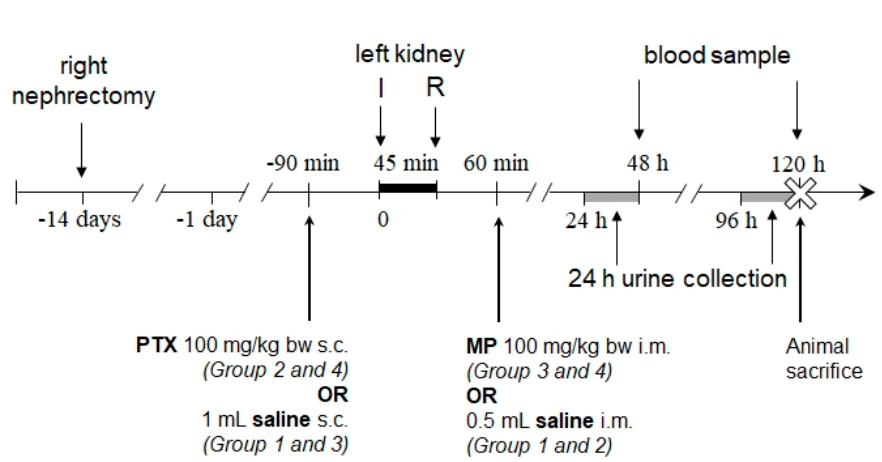
Figure 3. Scheme of the experiment of renal ischemia-reperfusion injury-induced acute kidney